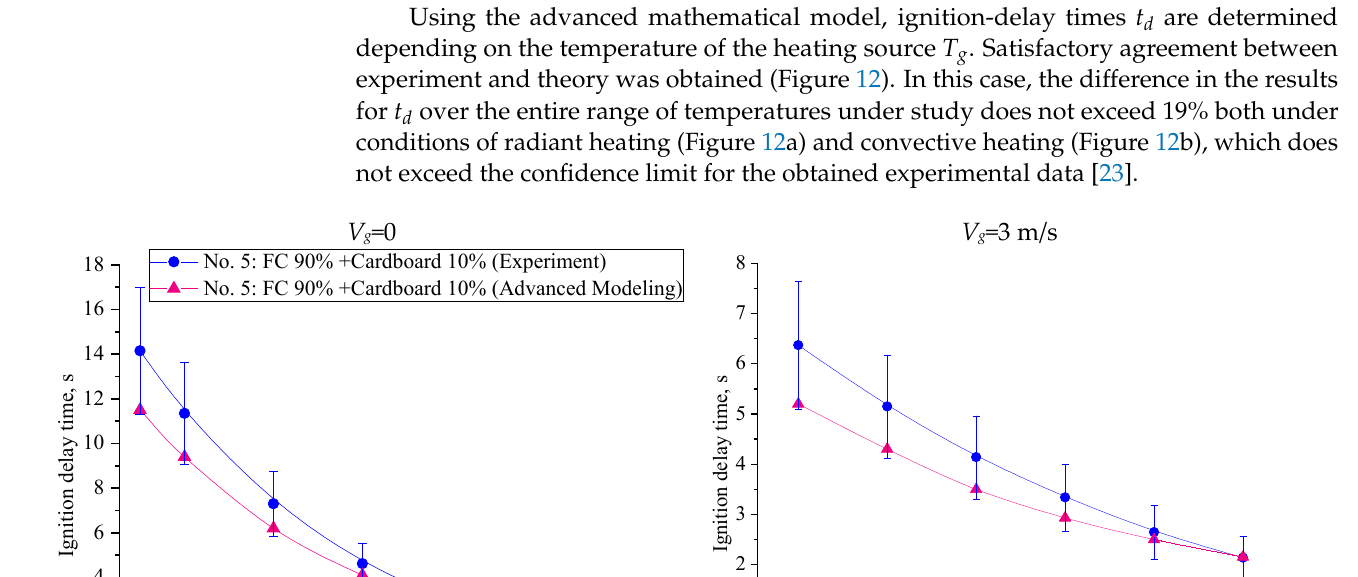
Figure 11. Temperature fields and videoframes obtained in experiments of ignition and combus- tion of CLF droplets No. 5 (FC 90% + cardboard 10%) at T g = 873 K [23] under the following condi- tions: ( a ) radiant heating ( V g ≈ 0); ( b ) convective heating ( V g ≈ 3 m/s). Using the advanced mathematical model, ignition-delay times t d are determined de- pending on the temperature of the heating source T g . Satisfactory agreement between ex- periment and theory was obtained (Figure 12). In this case, the difference in the results for t d over the entire range of temperatures under study does not exceed 19% both under con- ditions of radiant heating (Figure 12a) and convective heating (Figure 12b), which does not exceed the confidence limit for the obtained experimental data [23].